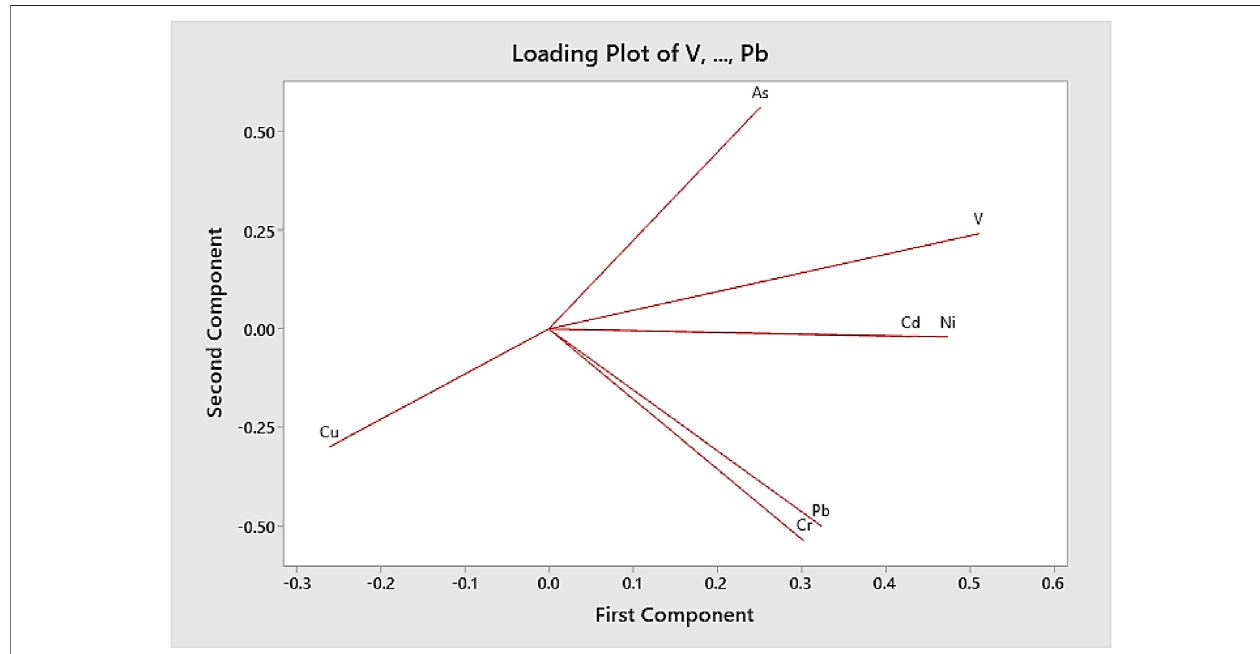
FIGURE 2 | PCA biplot of elemental concentrations in the vegetables samples.